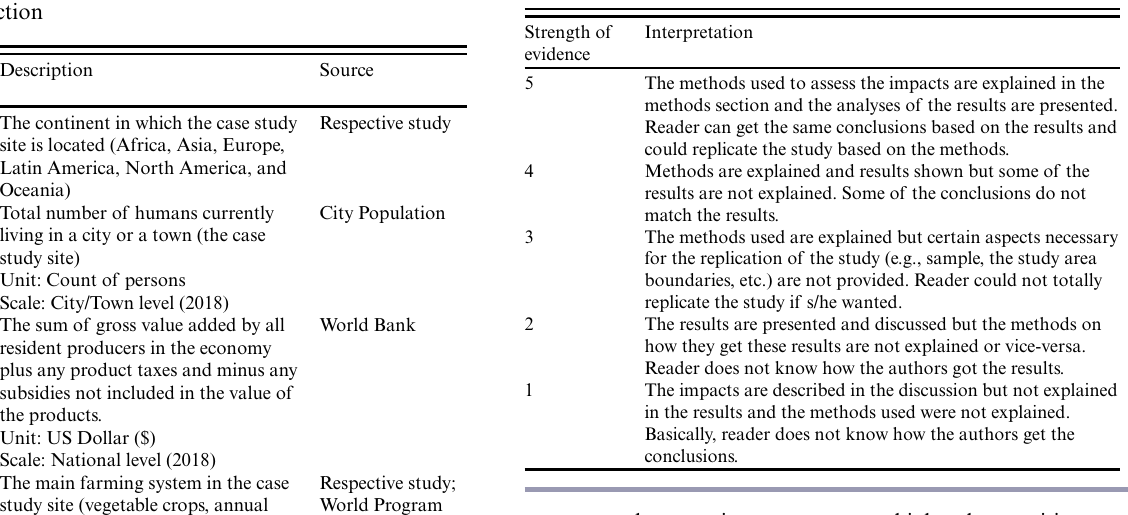
Table 3 . Strength of evidence of an outcome presented in a